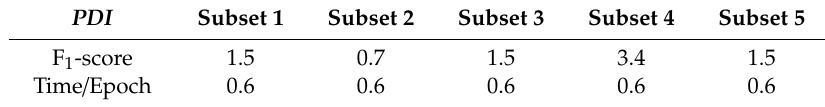
Table 6. Performance improvement of the proposed model compared with the DNN model.